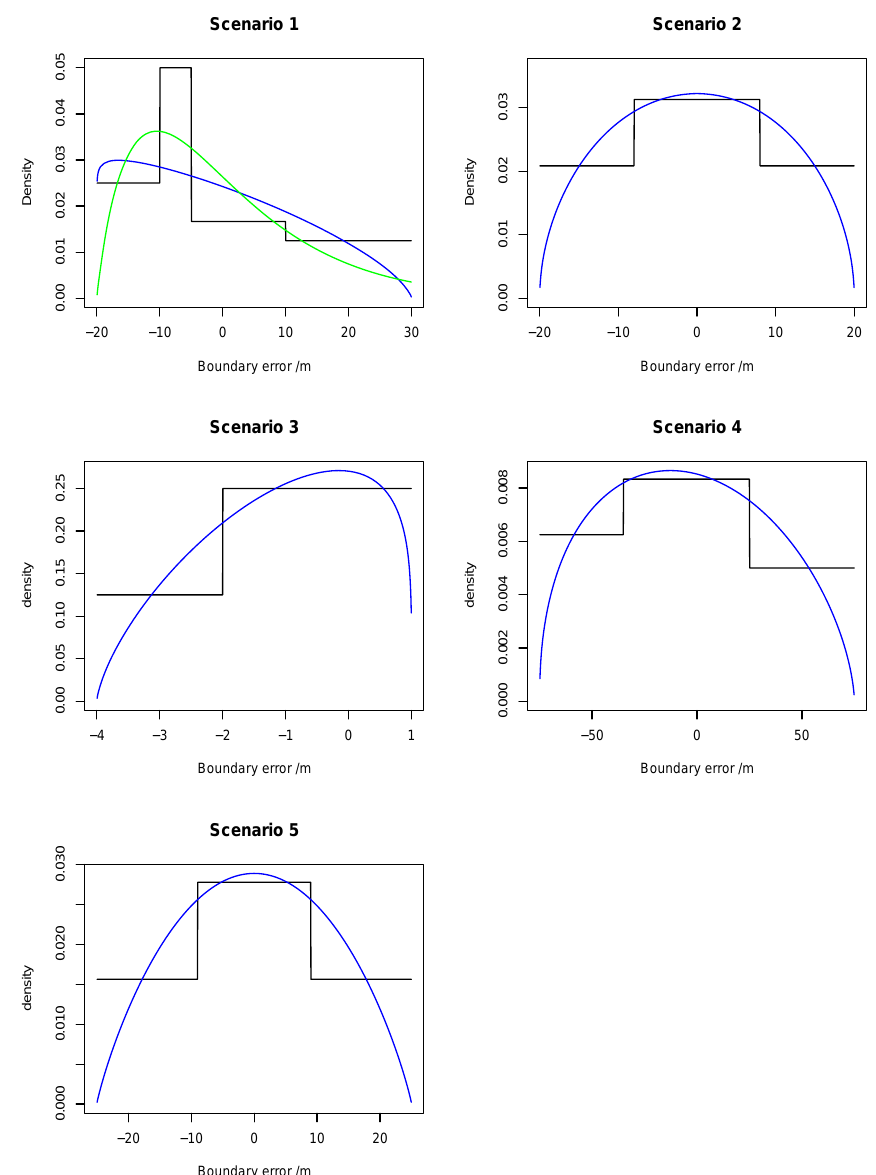
Figure 4. Best-fitting distributions for expert group quartiles, scenarios 1–5. Solid black line shows uniform density over elicited interquartile ranges, blue line show best-fitting distribution, green line shows closely competing alternative